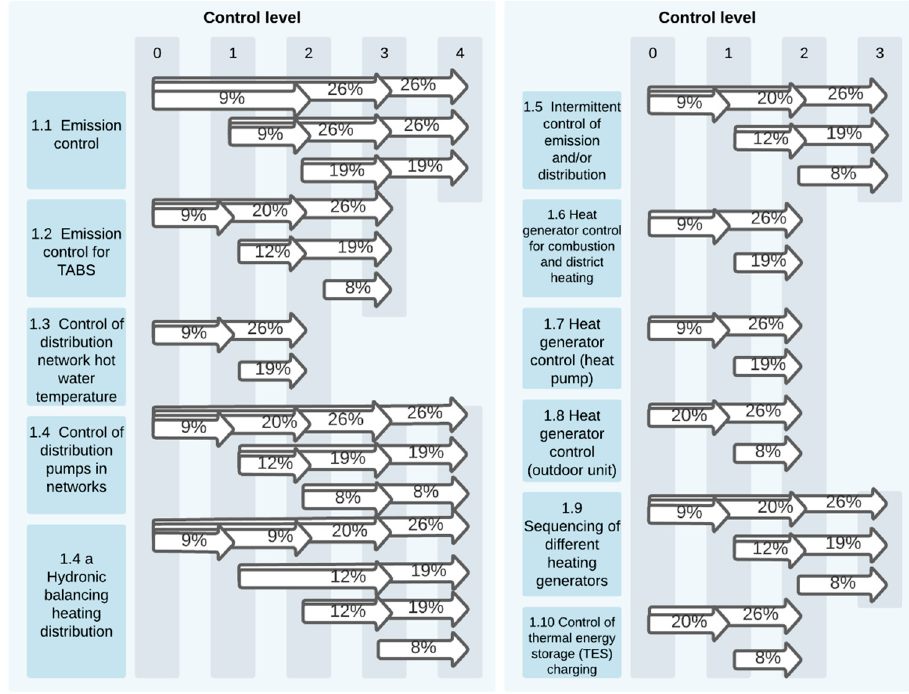
Figure 4. Potential savings for separate heating service control level upgrades for residential apart- ment